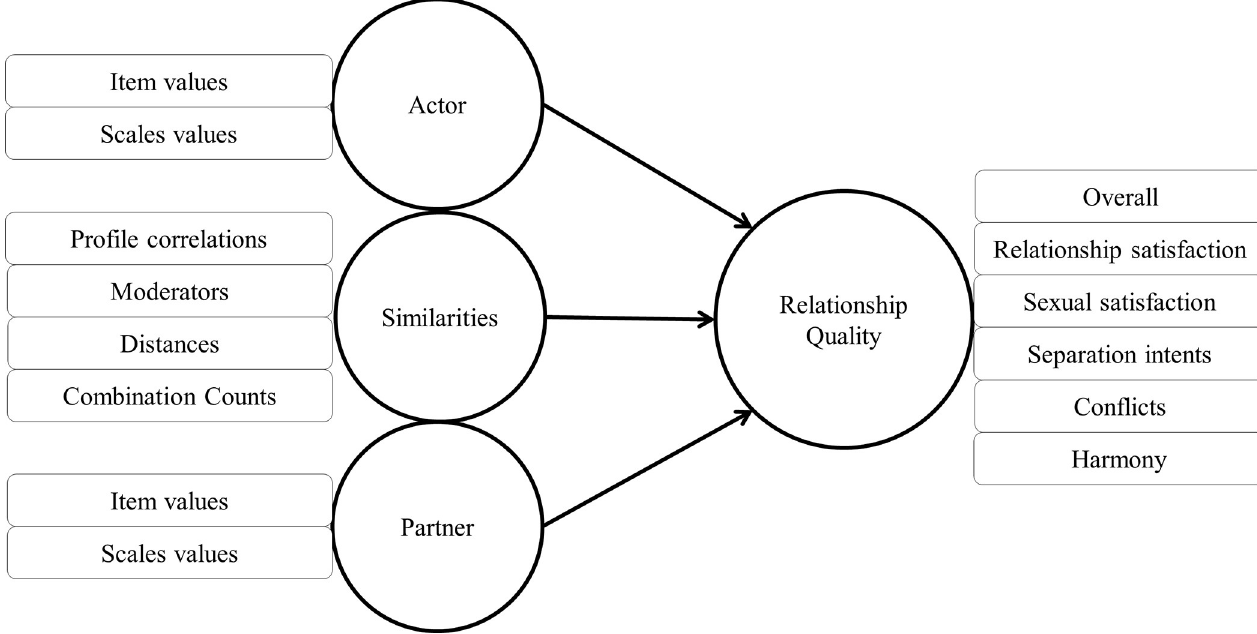
Fig 1. Linear regression model to predict RQ using personality variables. Different RQ measures on the right were predicted by different sets of personality scores on the left. CC: Combination Counts. RQ: Relationship Quality.